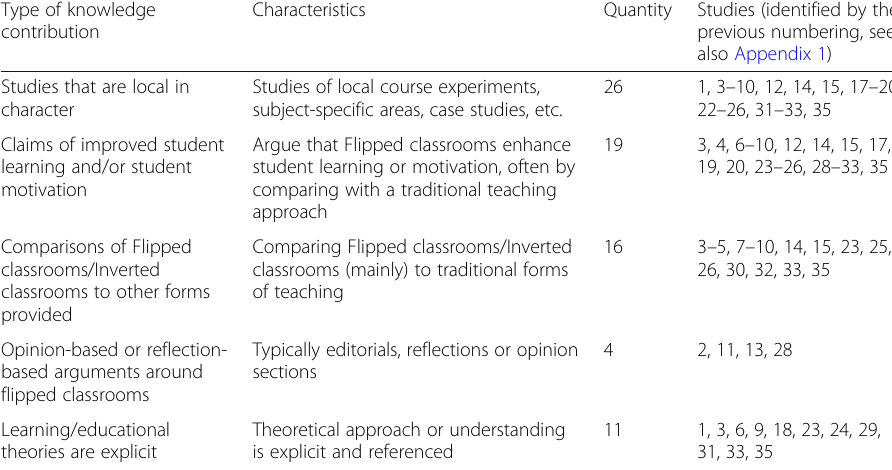
Table 3 Types of knowledge contributions based upon review sample ( N =